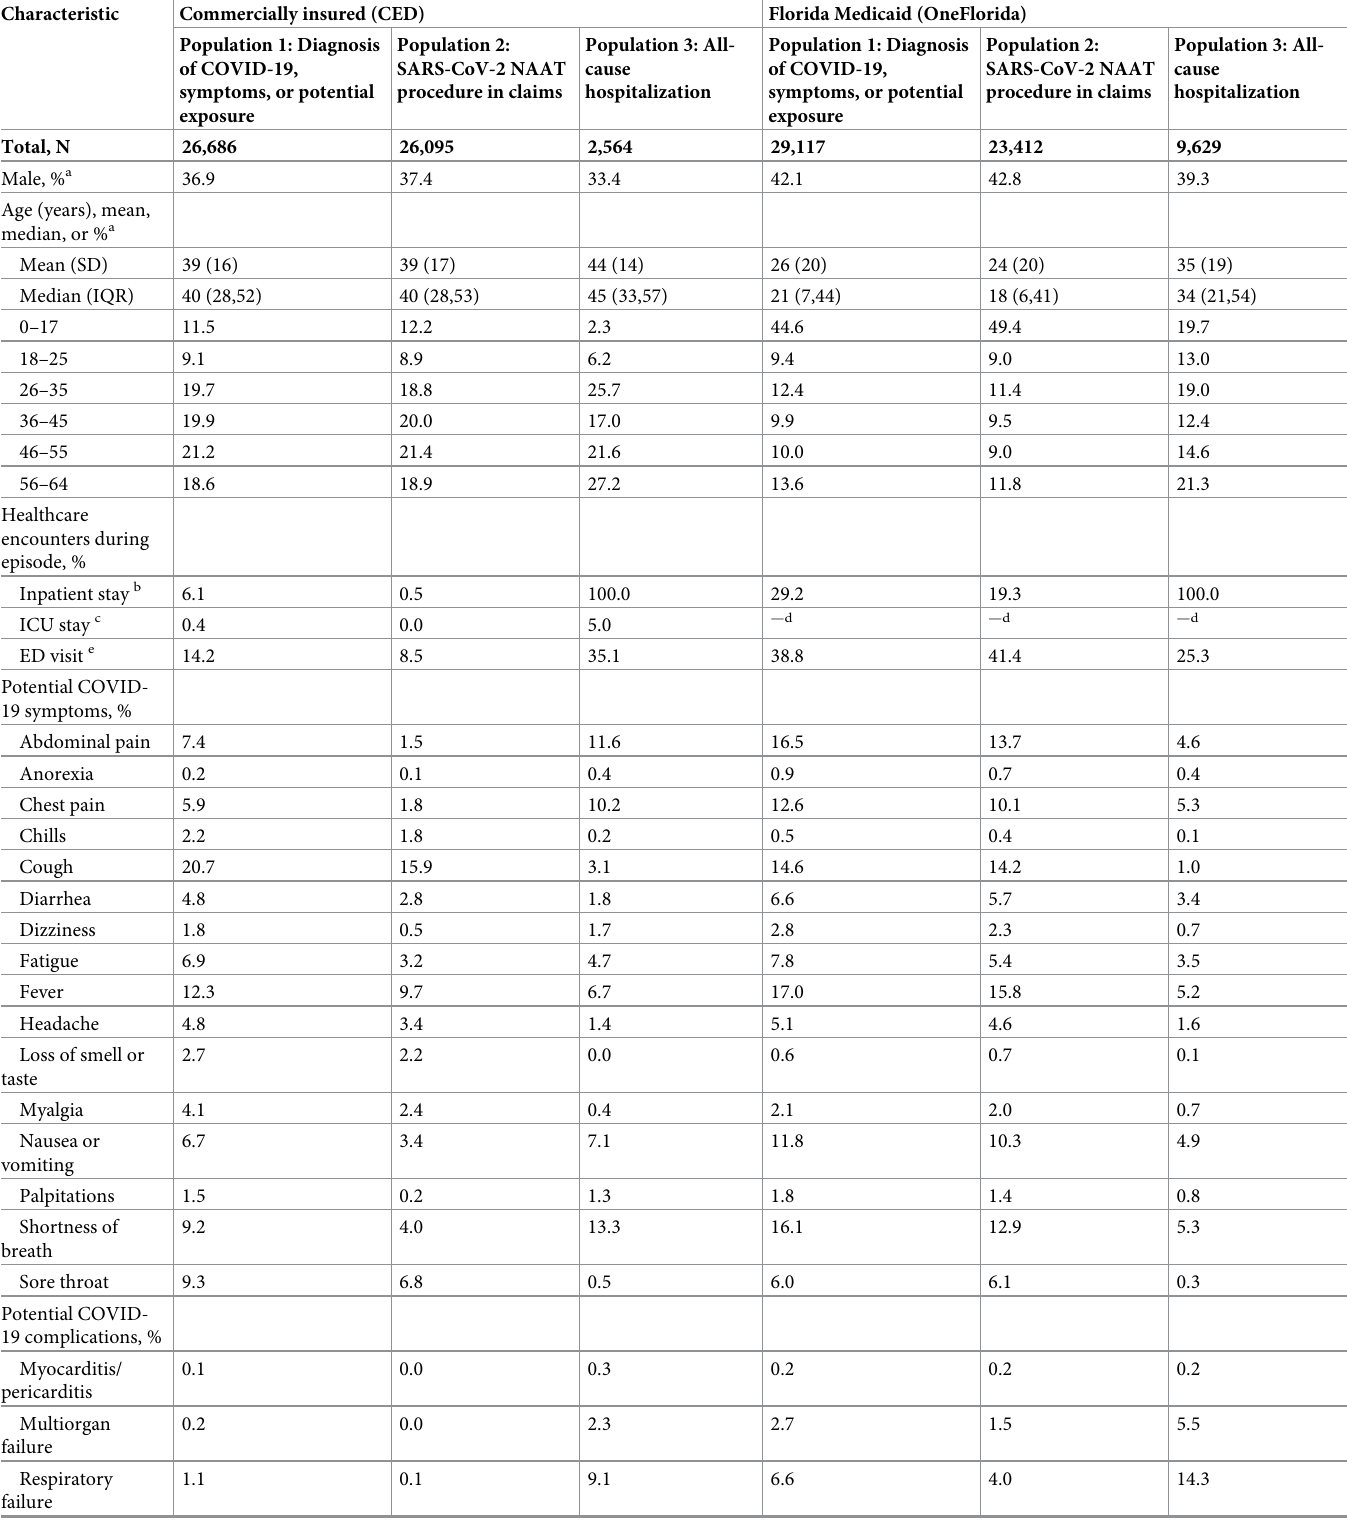
Table 2. Characteristics of the study